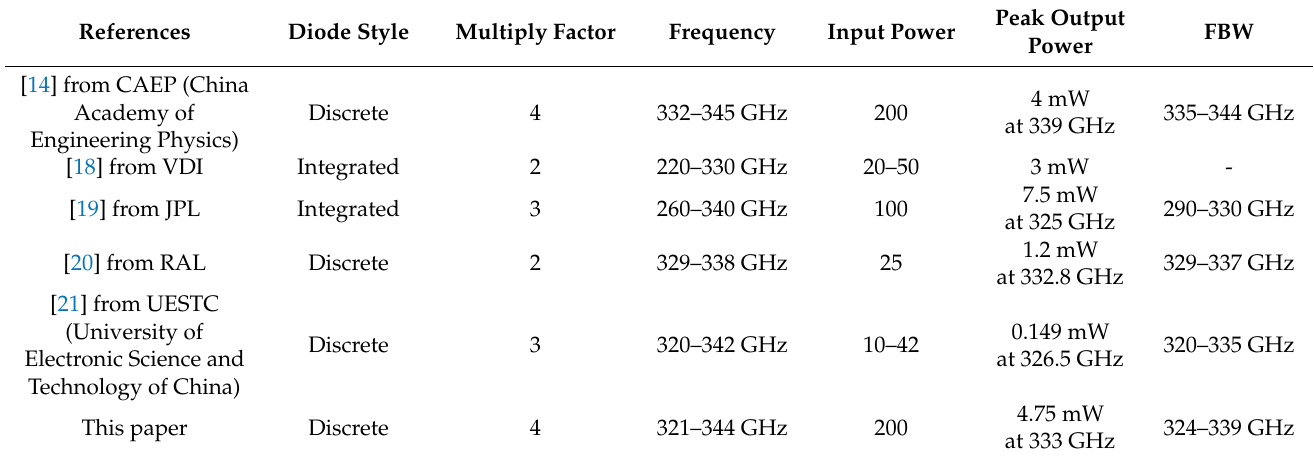
Table 1. Performance comparison of the frequency multipliers working above 330 GHz.